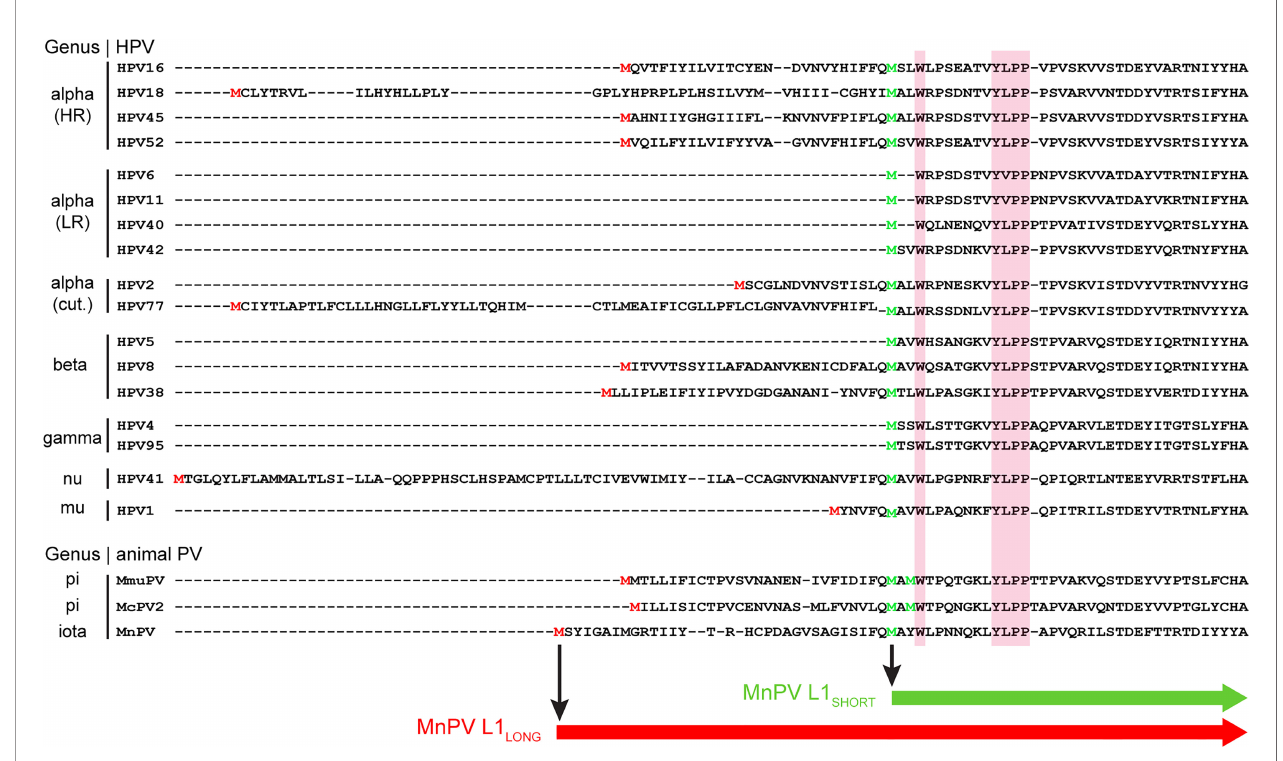
FIGURE 1 | Localization of the MnPV L1 isoforms in comparison to other PV types. N-terminal amino acid sequences of L1 major capsid proteins from certain high- risk (HR), low-risk (LR) or cutaneous (cut.) HPVs and animal PV types of different genera were aligned using Clustal Omega. Pink boxes: highly conserved Wx7YLPP motif common to both human and animal PVs. Green M: methionine upstream of the Wx7YLPP motif initiates L1 SHORT .Red M: upstream in-frame methionine of L1 LONG . Figure modi fi ed from